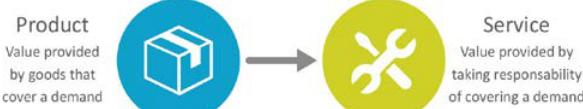
Figure 3 . Change from product to service oriented solu- tions and